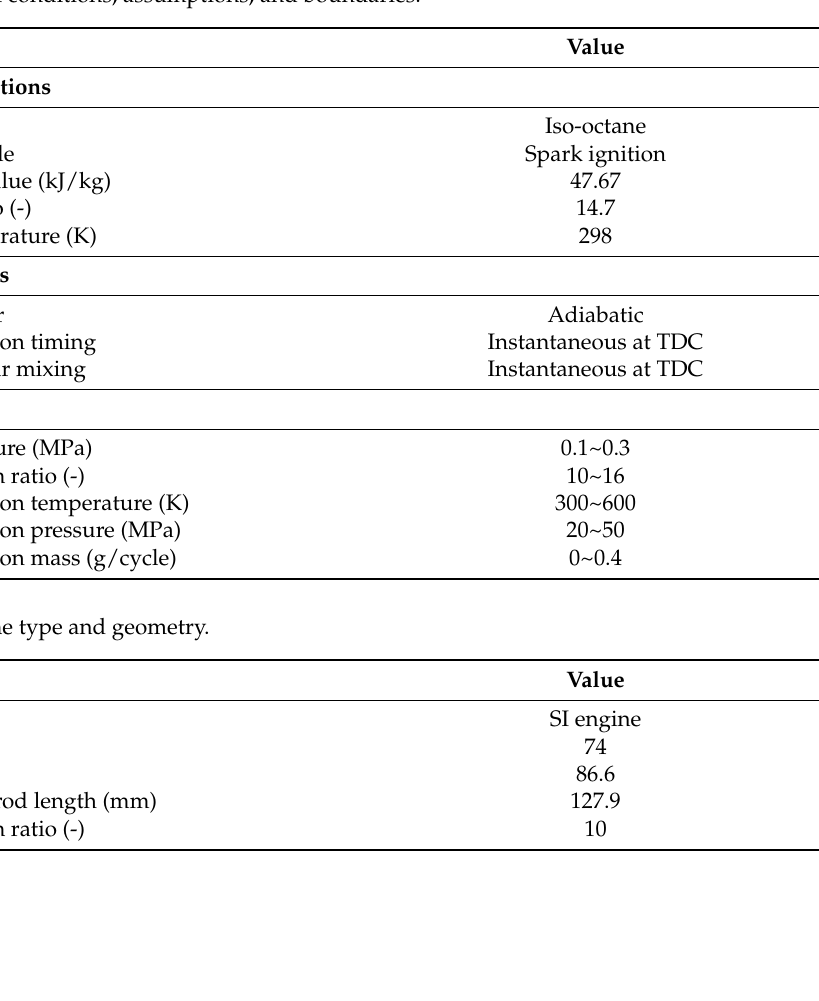
Table 1. Initial conditions, assumptions, and boundaries.